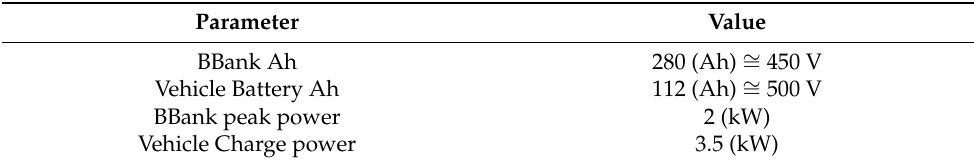
Figure 15. Active power consumed from the household for a typical day. Other system parameters are given in Table 1. Table 1. Key system parameters.